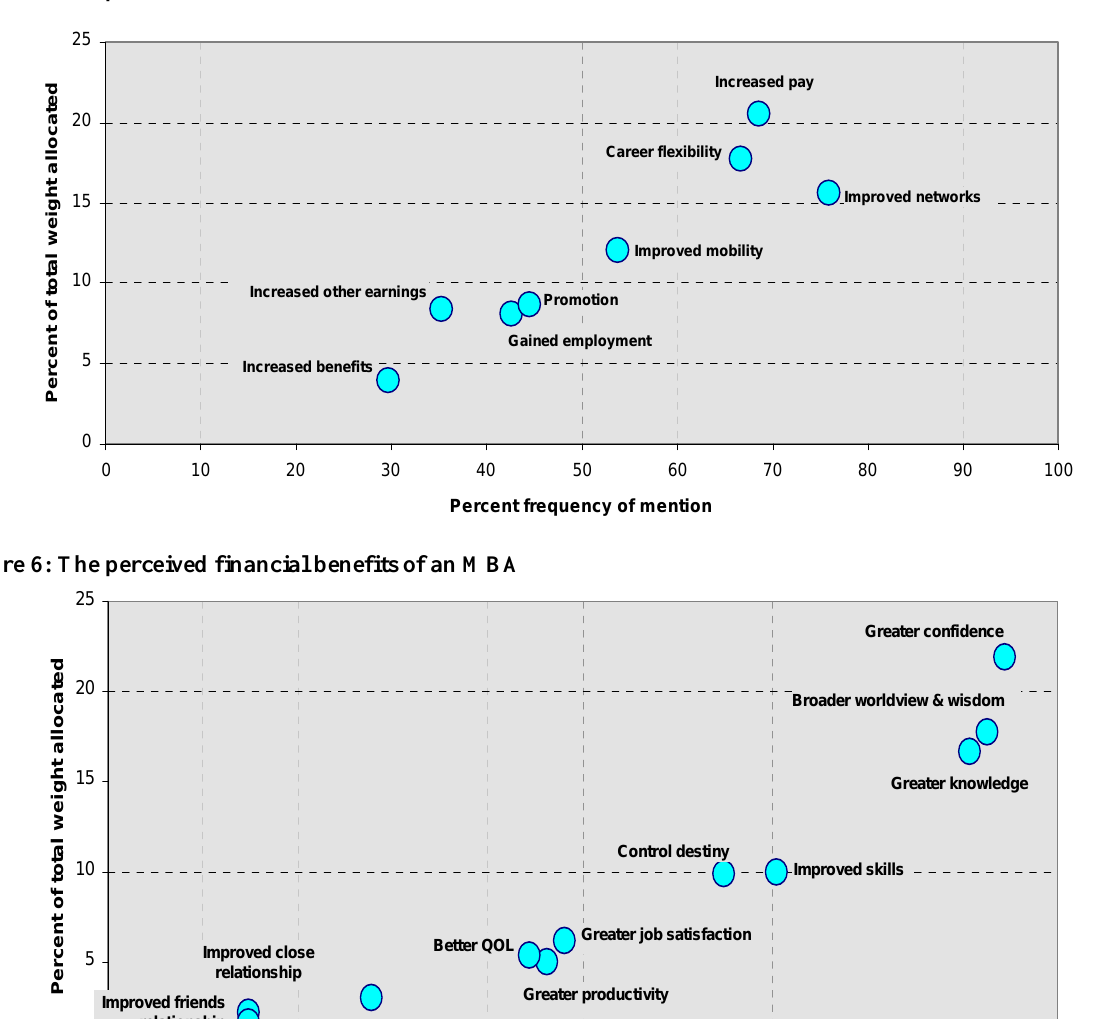
Figure 5: The perceived non-financial costs of an MBA